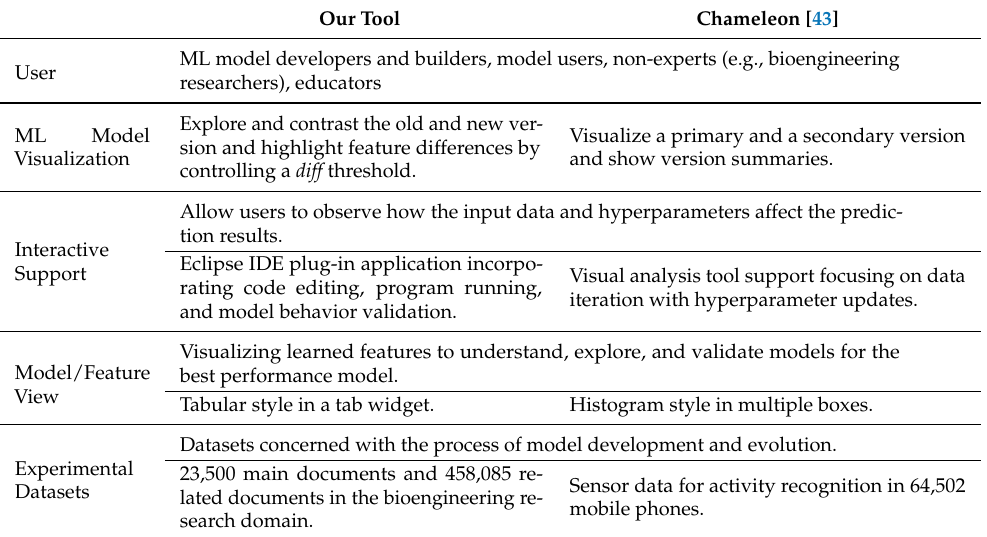
Table 1. Visual analysis feature comparison with an existing approach for data exploration and